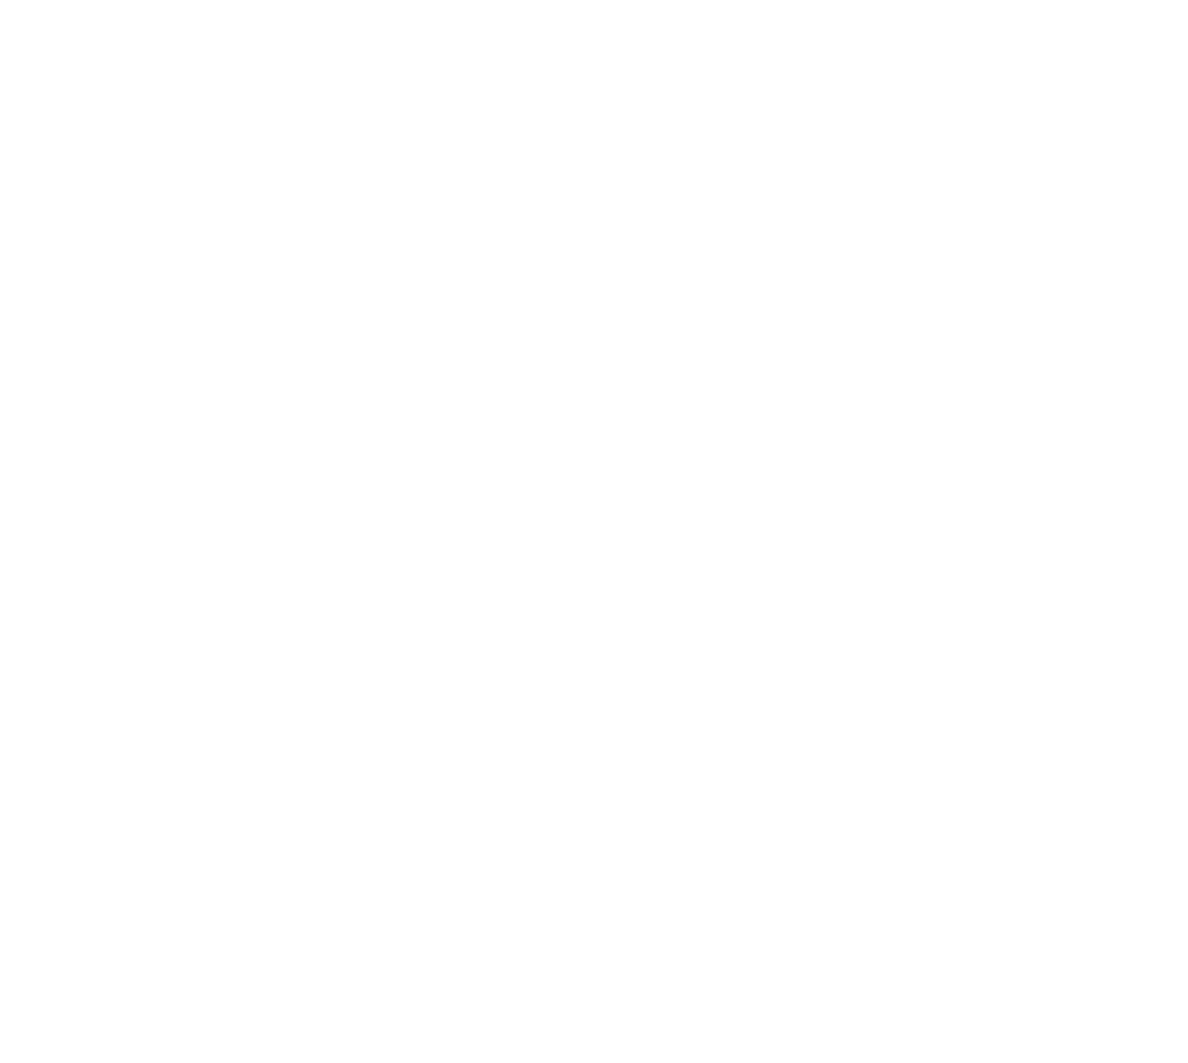
Frontiers in Pharmacology |